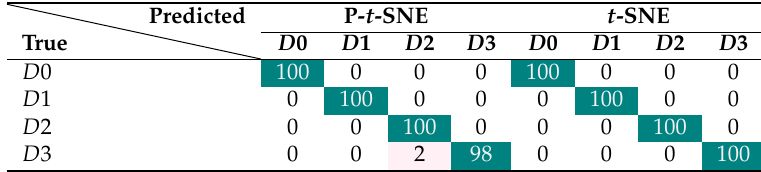
Table 1. Confusion matrix of the application of P- t -SNE and t -SNE damage detection and classification method presented in Sections 3 and 4: scenario 1 and the majority voting approach. Predicted P- t -SNE t -SNE D 0 D 1 True